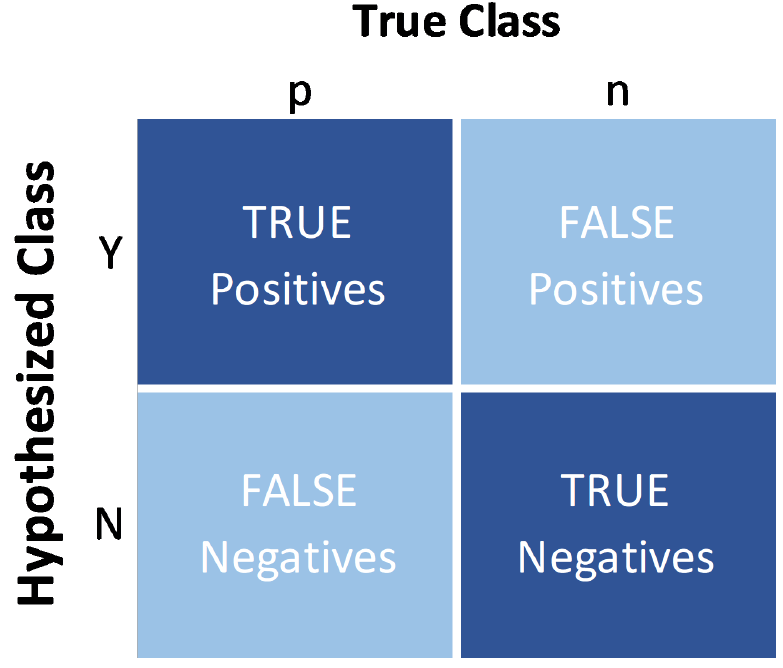
Figure 6. Confusion matrix and possible outcome of binary